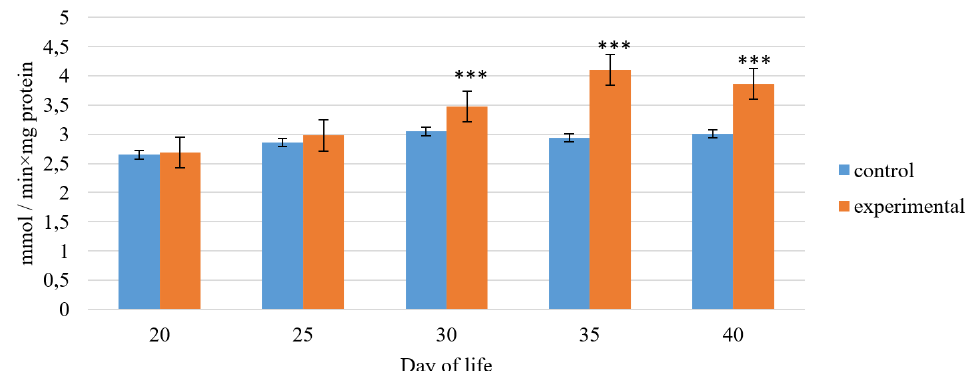
Fig. 2. Catalase activity in the blood of piglets under the action of feed additive “Butaselmevit-plus” On the 35th day of the life of piglets, a decrease in cata- lase activity was found in the control group, while in the experimental group the activity of this enzyme increased by 39.5 %, respectively.